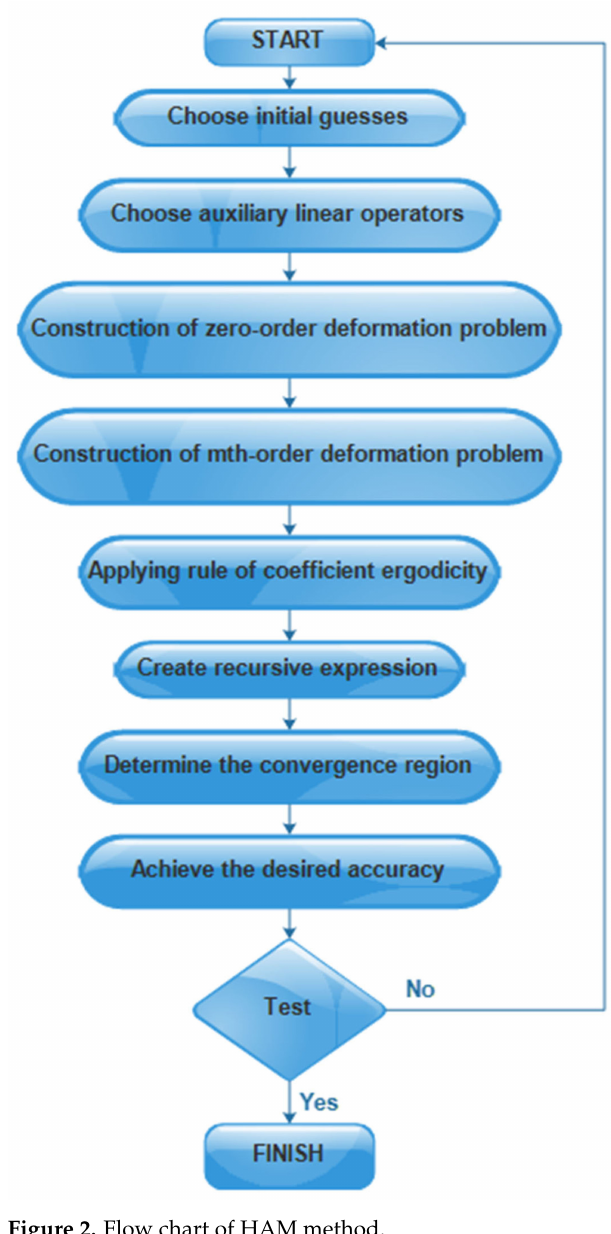
Figure 2. Flow chart of HAM